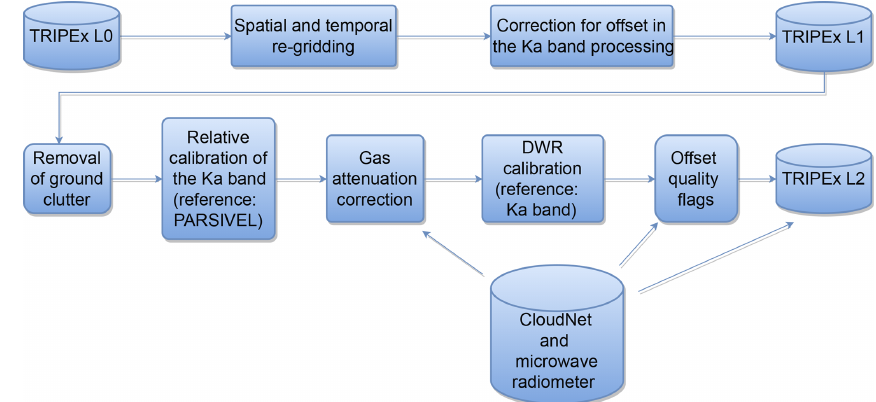
Figure 2. Flowchart of the TRIPEx data processing. The upper part describes the steps producing data Level 1 and the bottom part those producing data Level 2.